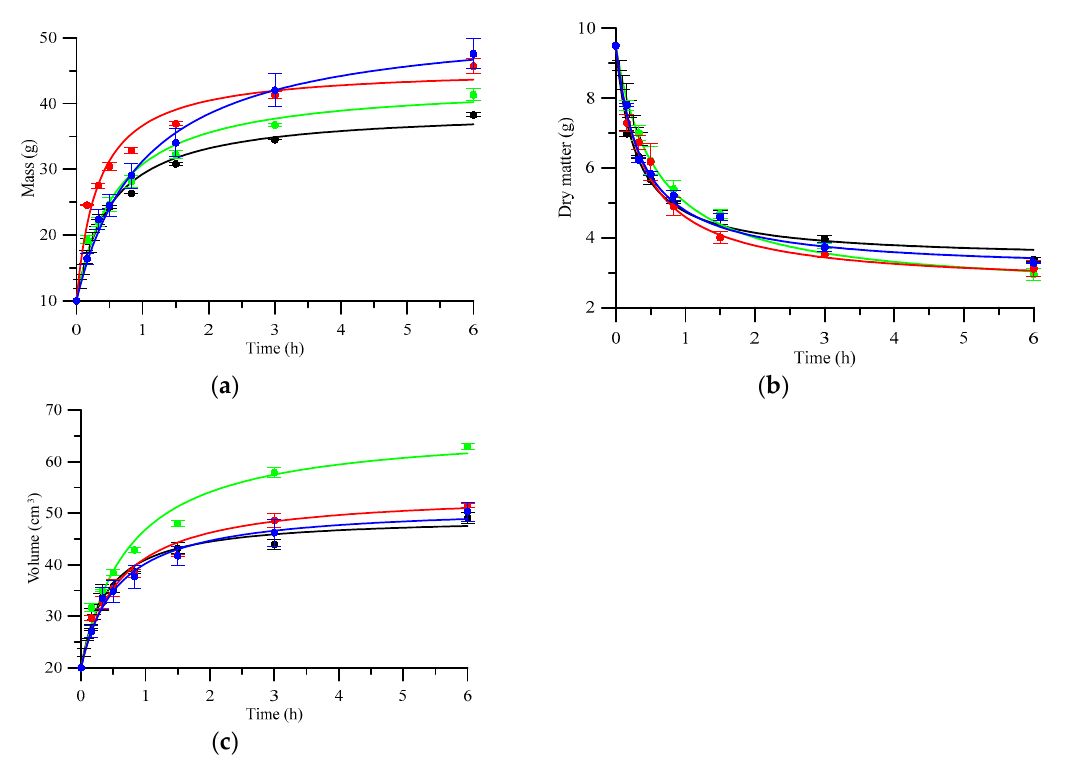
Figure 1. Mass vs. time ( a ), dry matter vs. time ( b ) and volume vs. time (c) for the rehydration (at 20 ◦ C) of dried apples of di ff erent varieties: (——)—Champion, (——)—Cortland, (——)—Gray Reinette, ( −−− )—Ligol.